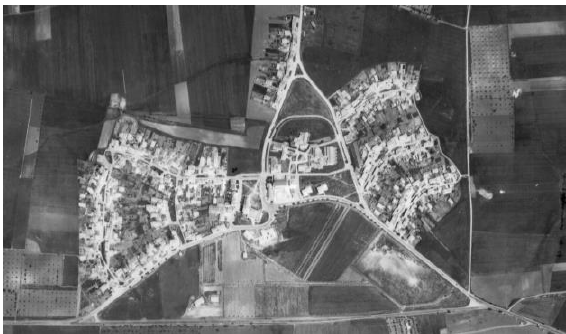
Figure 1. Aerial photo of the original rural village of U.N.R.R.A. Casas “La Martella” in Matera (© ICCD Archivio